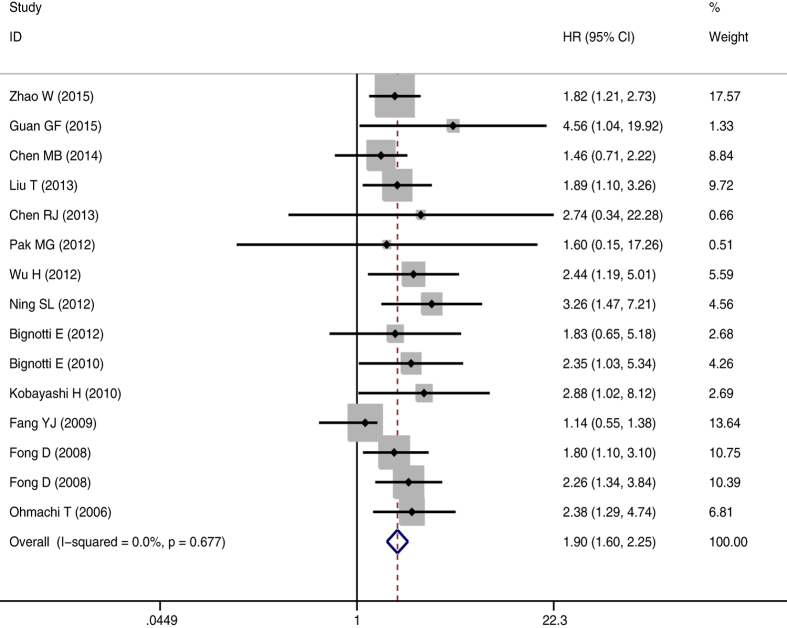
The correlation between TROP2 expression and overall survival (OS) in solid tumors.